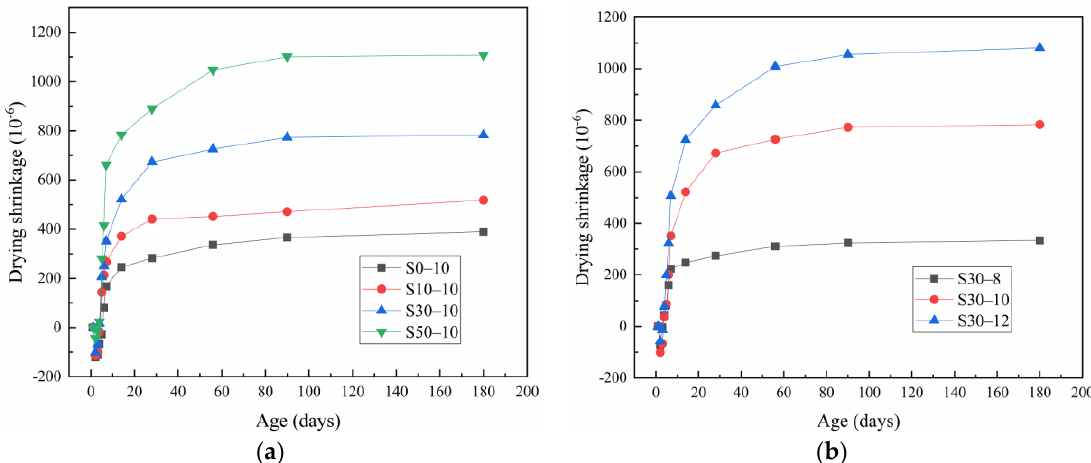
Figure 4. Drying shrinkage of the alkali-activated metakaolin-based geopolymers specimens accord- ing to the ( a ) slag and ( b ) Na 2 O content. ing to the ( a ) slag and ( b ) Na 2 O